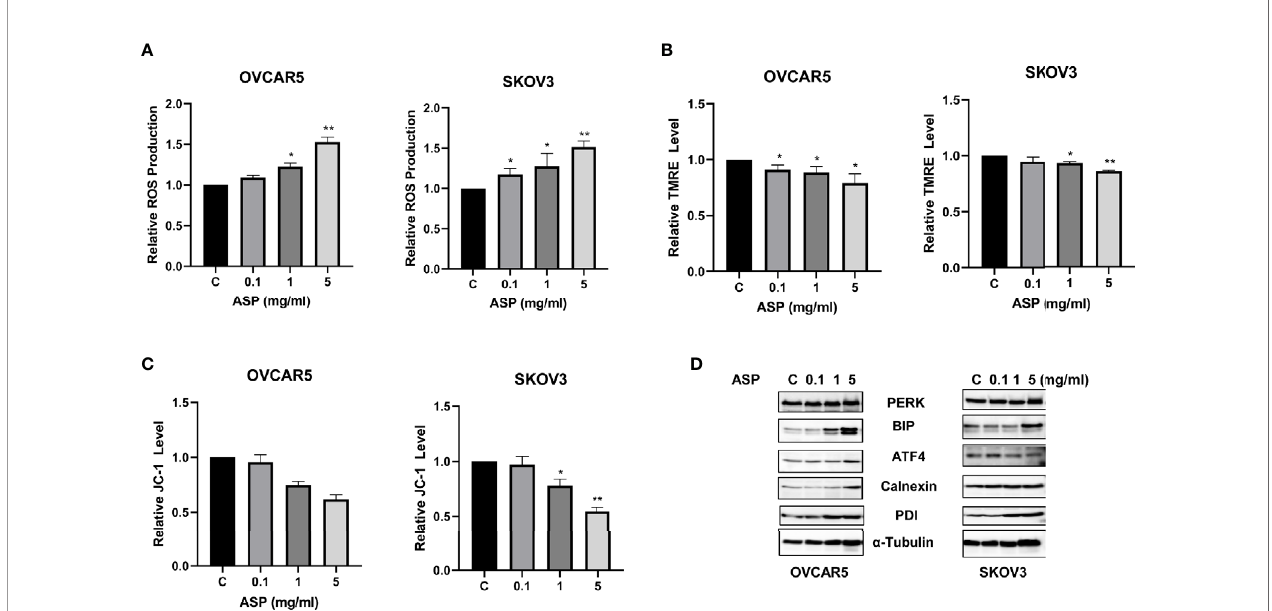
FIGURE 4 | ASP induced cellular stress in OC cells. Effects of ASP on ROS, JC-1 and TMRE products were measured by ELISA assays. ASP signi fi cantly increased the levels of ROS and decreased JC-1 and TRME products in both cell lines compared to the control-treated cells after 8 hours of treatment (A – C) . The results from Western blotting analysis showed that ASP increased the expression of the cellular stress related proteins in both cell lines after treatment for 24 hours, including PERK, Bip, ATF4, Calnexin and PDI (D) . *p < 0.05; **p < 0.01.